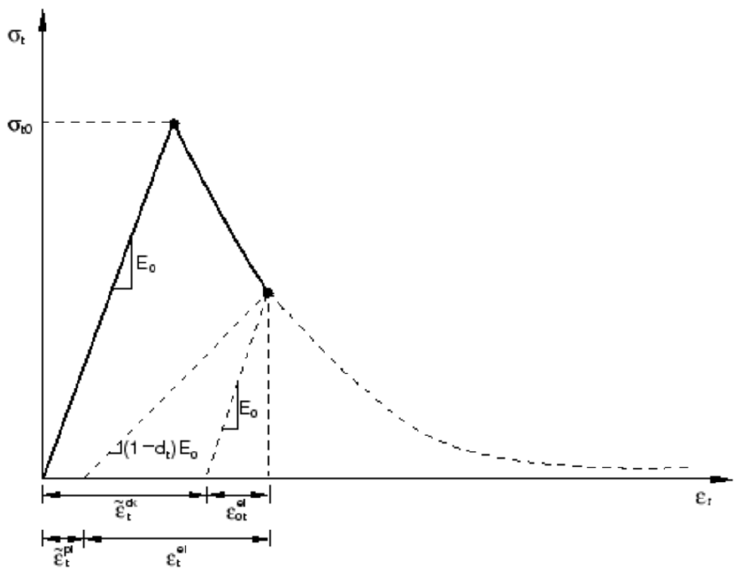
Figure 15: CDP stress–strain curve for concrete in tension (Abaqus Analysis User’s Guide,